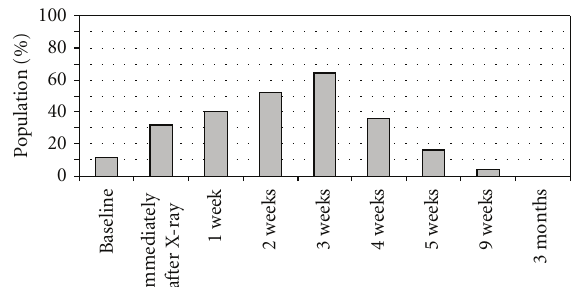
Figure 1: Percentages of patients with ulcerative BCC at baseline (immediately before X-ray therapy), and radiotherapy induced ulcerations at di ff erent time points after completed X-ray therapy ( n =